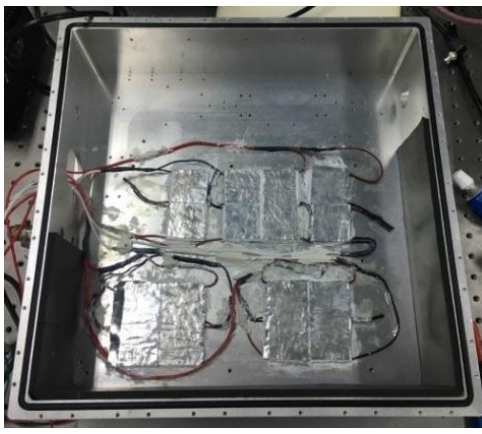
Figure 5. Picture of TEC layout. Table 1. TEC parameters.